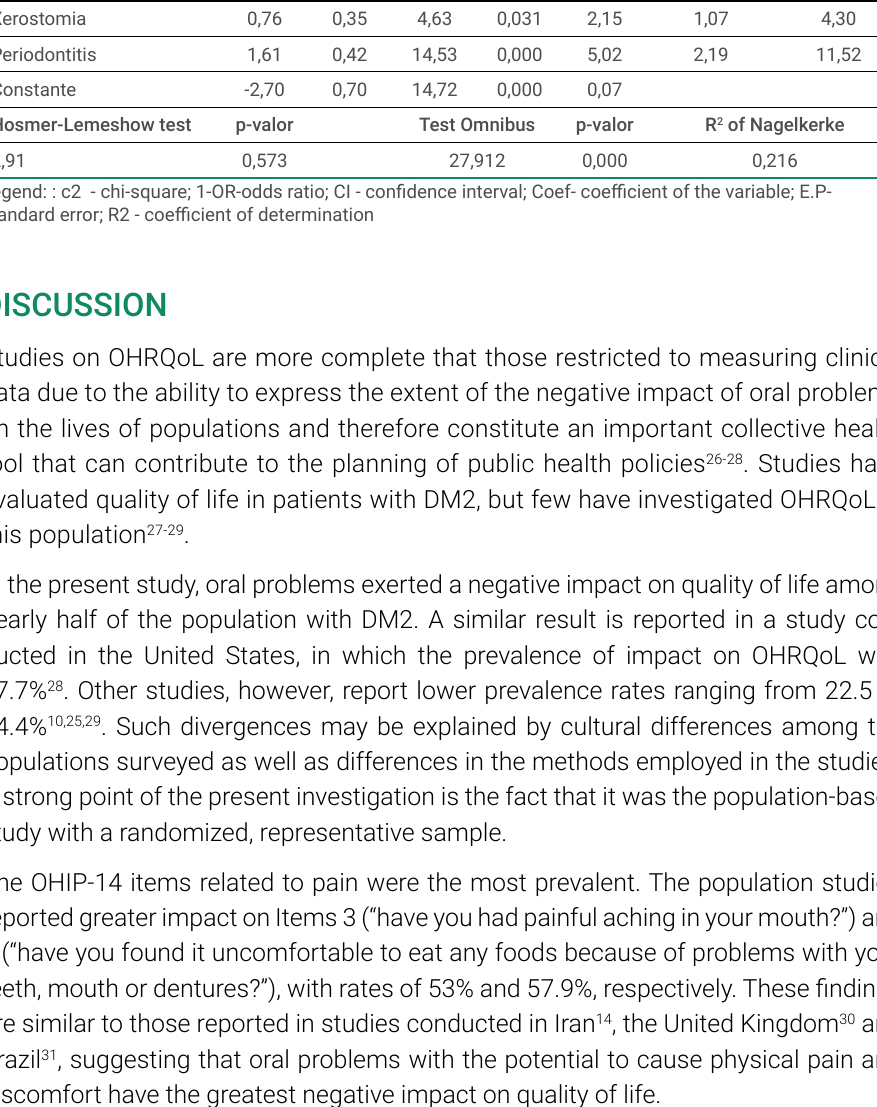
IC 95% Minimum Maximum